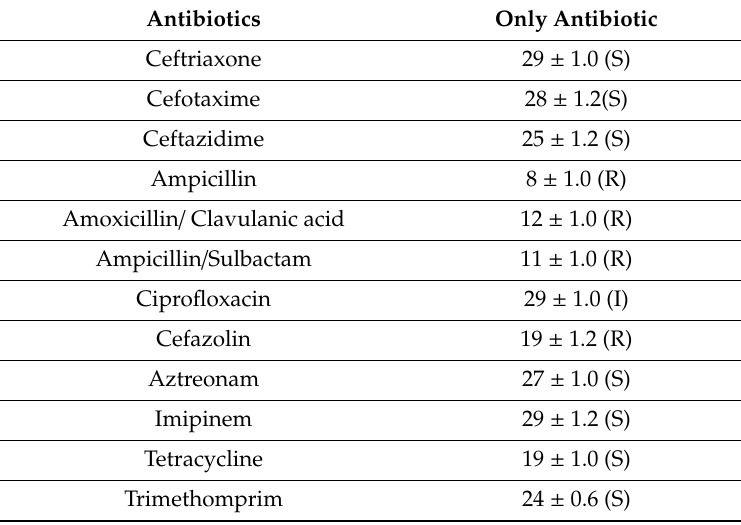
Table 2. Zone of inhibition (mm) and susceptibility of di ff erent antibiotics against Enterotoxigenic Escherichia coli